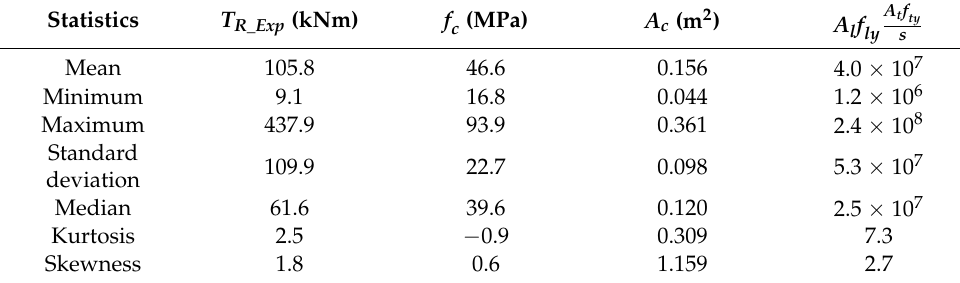
Table 3. Statistical measures of the variables for the testing